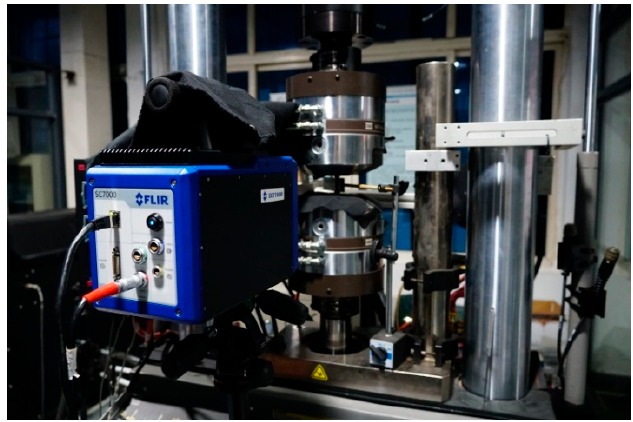
Figure 5. Installation diagram of the fatigue test and thermal measurement.